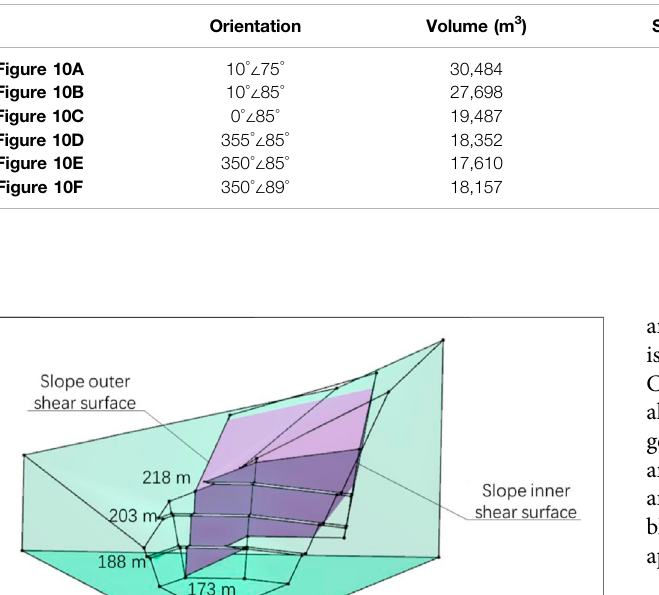
TABLE 4 | Block stability with different shear surface orientations.